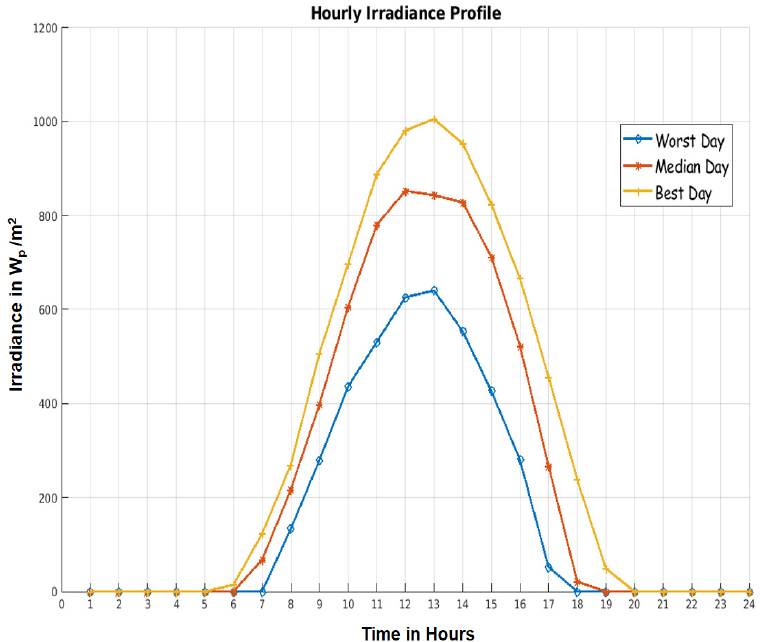
Figure 8. Hourly irradiation profile for best, median and worst day scenario for PV farm. In this figure, W p /m 2 represents Watt-peak per sq. meter.